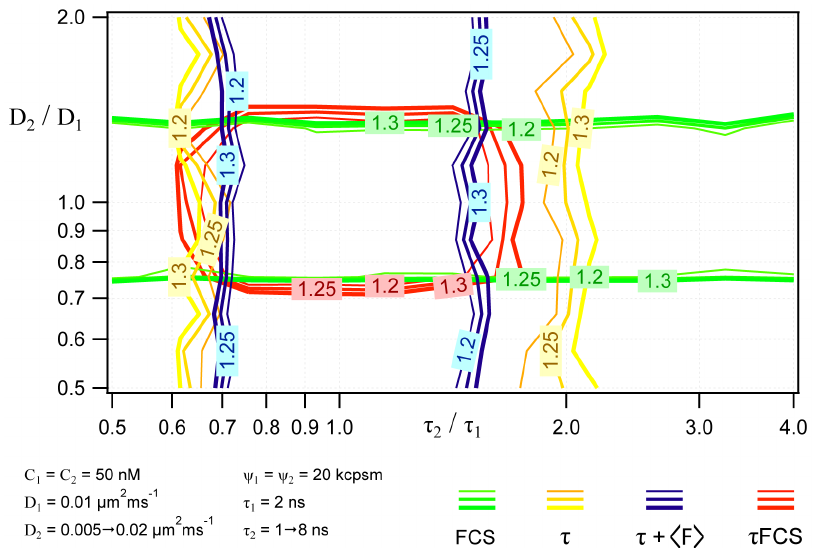
Figure 3. Identifying a second component from simulated mixture data via incorrect single component analysis. These curves shown represent the chi-squared contours for the different fitting methods when fitting two-component data with a single component model. When the x 2 value exceeds , 1.3 we conclude that the single component analysis fails, indicating the presence of a second component in the sample. Four x 2 surfaces demonstrate the boundary in parameter space for 1) FCS (green lines); 2) Fluorescence Lifetime (yellow lines); 3) Fluorescence Lifetime with average intensity constraint (blue lines); and 4) t FCS with average intensity constraint (red lines).